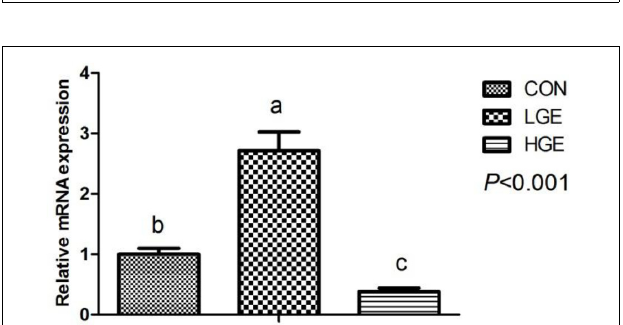
FIGURE 3 | Effect of dietary GEN on GnRH mRNA expression in the hen hypothalamus ( n = 8 replicates). Data represent the mean ± SEM of the values. Mean values without a common identifier (a, b, and c) differ significantly among the three groups ( P < 0.05).